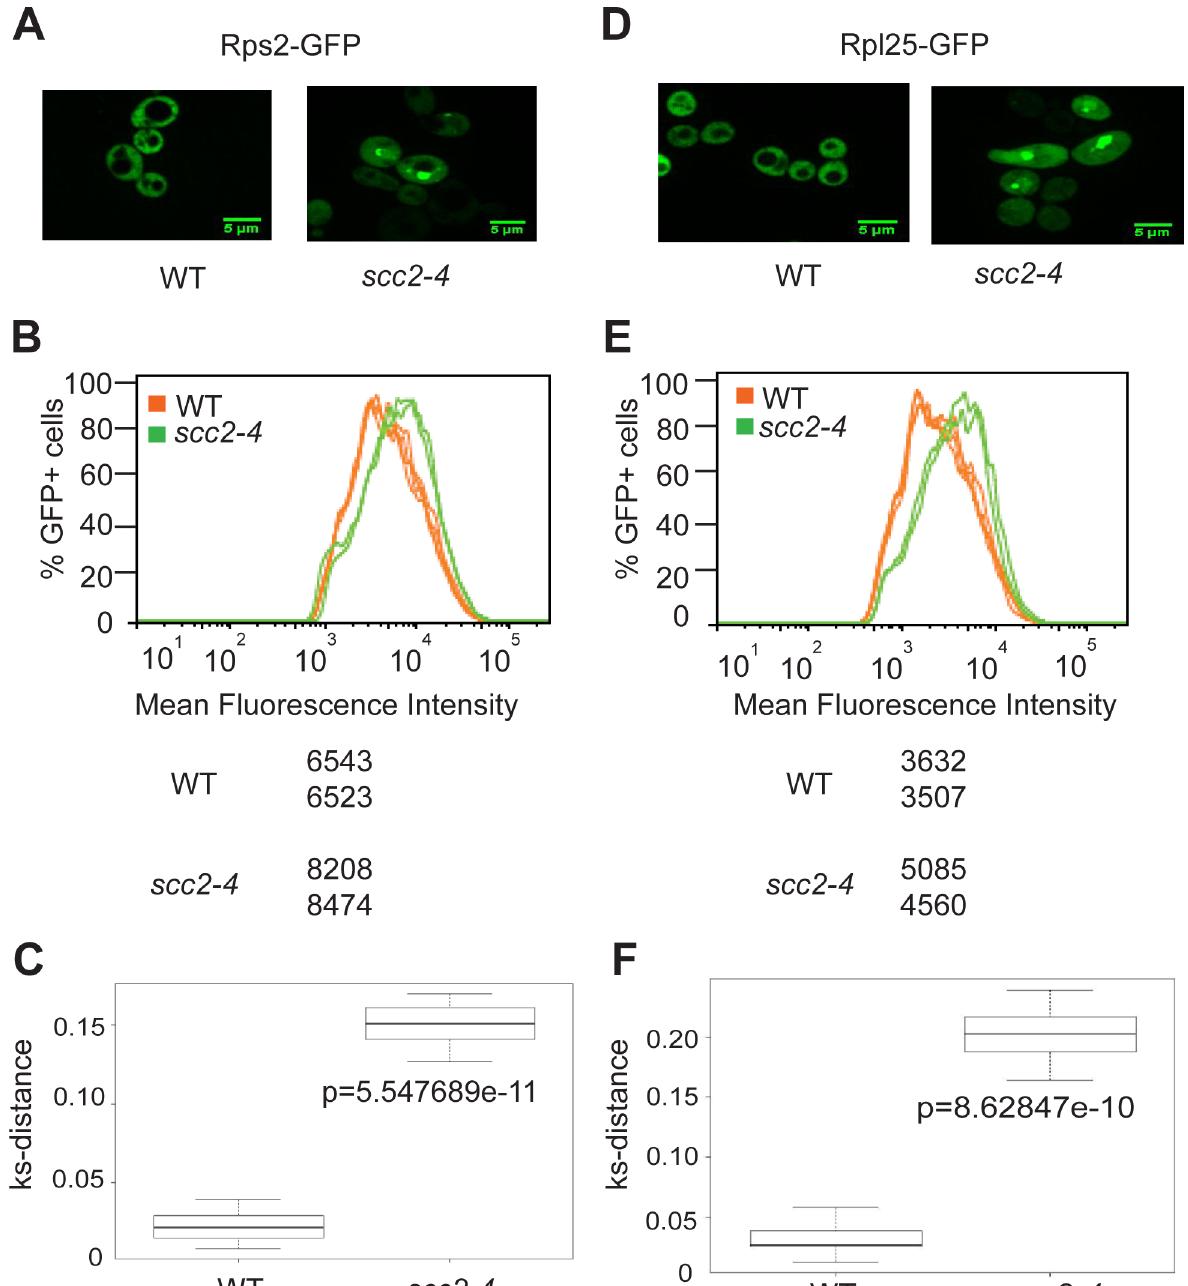
Fig 5. Ribosome protein distribution is compromised in the scc2-4 mutant. Protein components of the small (Rps2) and large (Rpl25) ribosomal subunits were tagged with GFP and imaged. Representative images are shown for WT and mutant strains (A and D). Using flow cytometry, the peak GFP intensity was quantified for independent biological replicates (B and E). At least 10000 cells were examined per replicate. A KS-distance was calculated from cumulative distribution frequency curves of the fluorescence which allows us to determine statistical significance (C and F) (p < 0.0001).